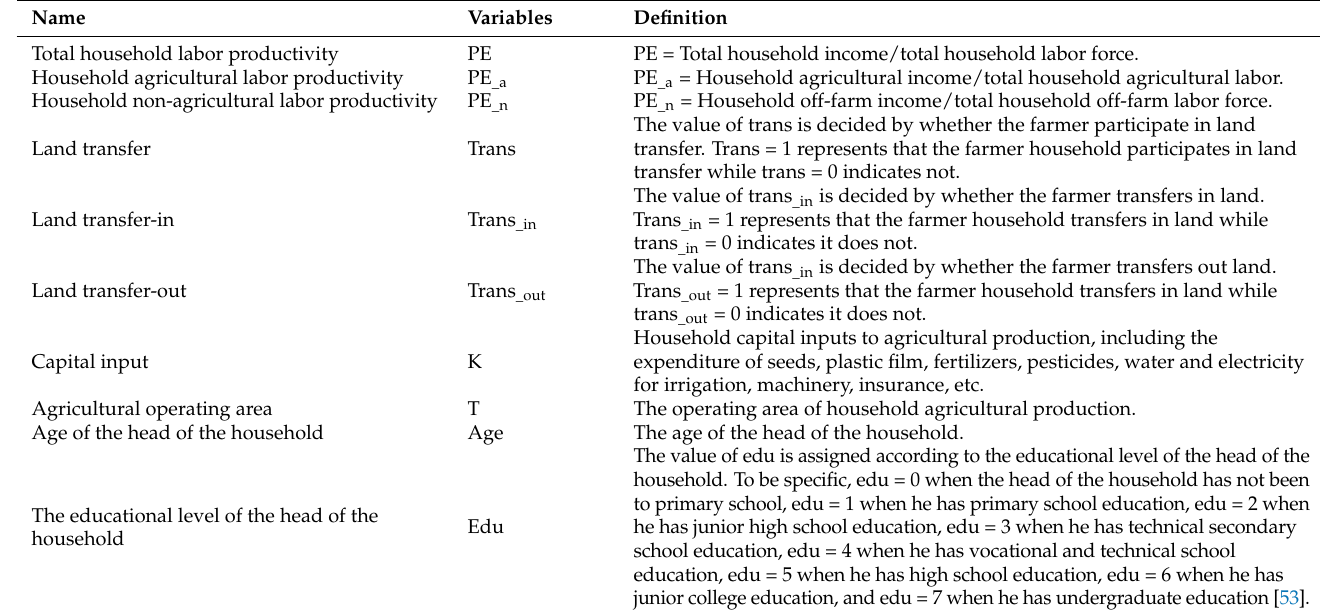
Table 4. Description of